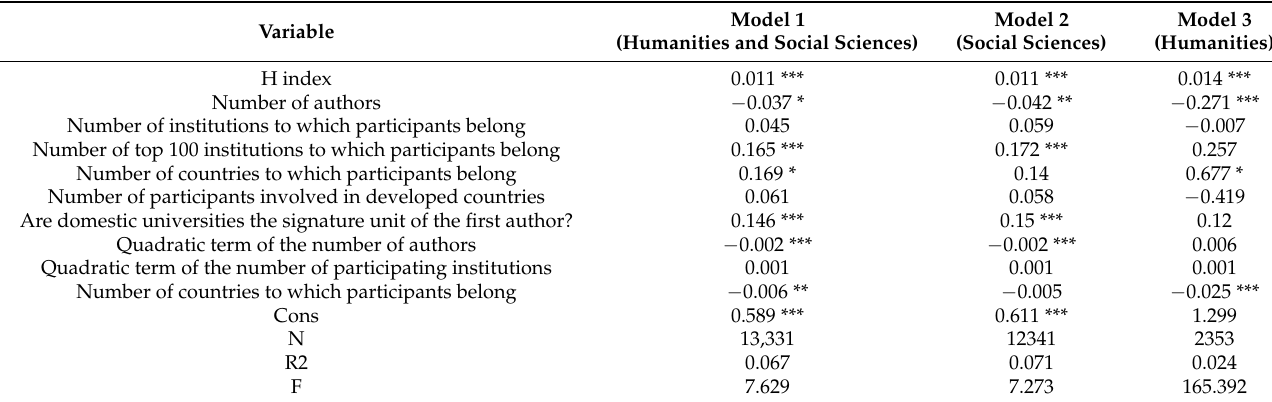
Table 5. Regression analysis results (dependent variable is the impact of discipline